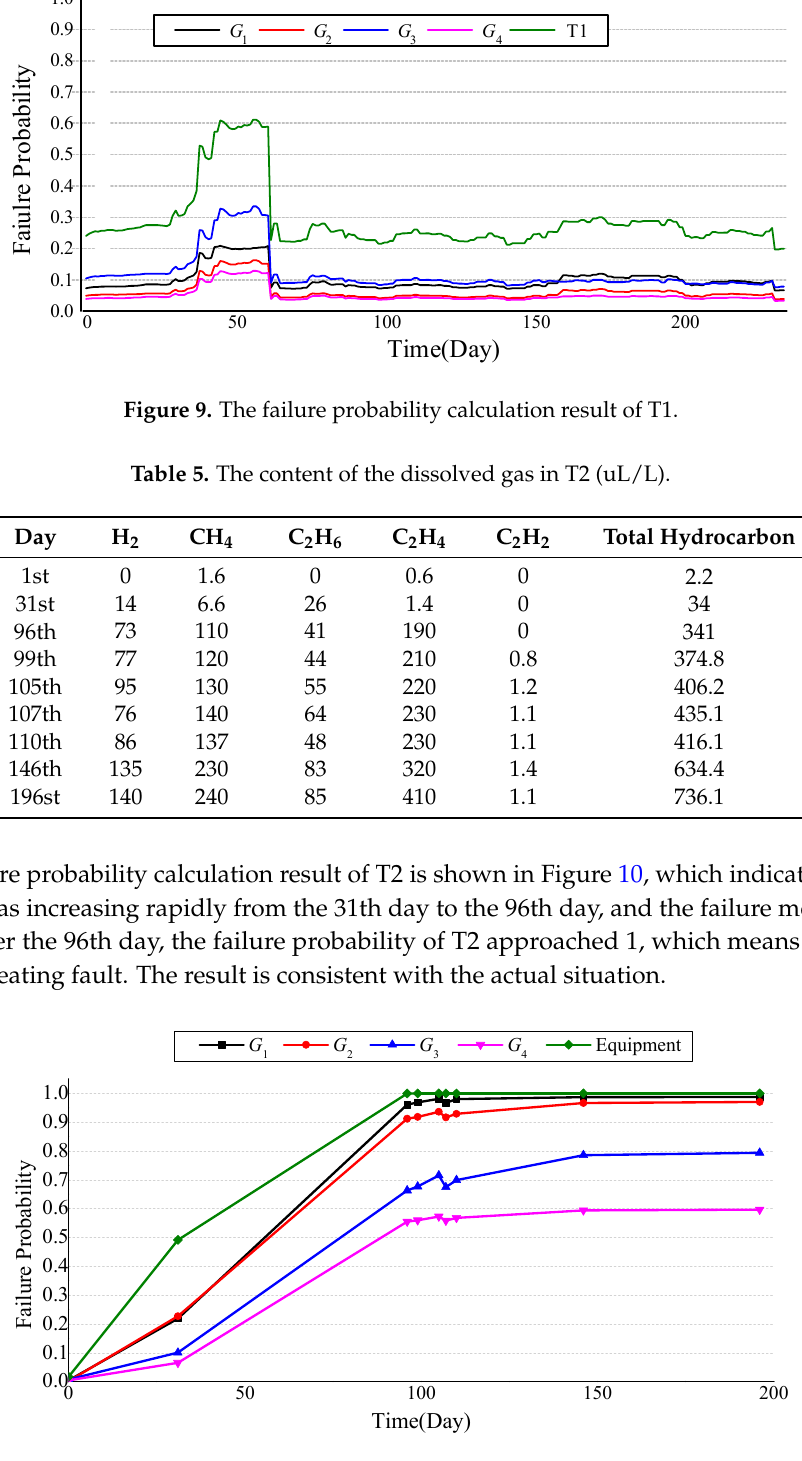
Figure 9. The failure probability calculation result of T1.